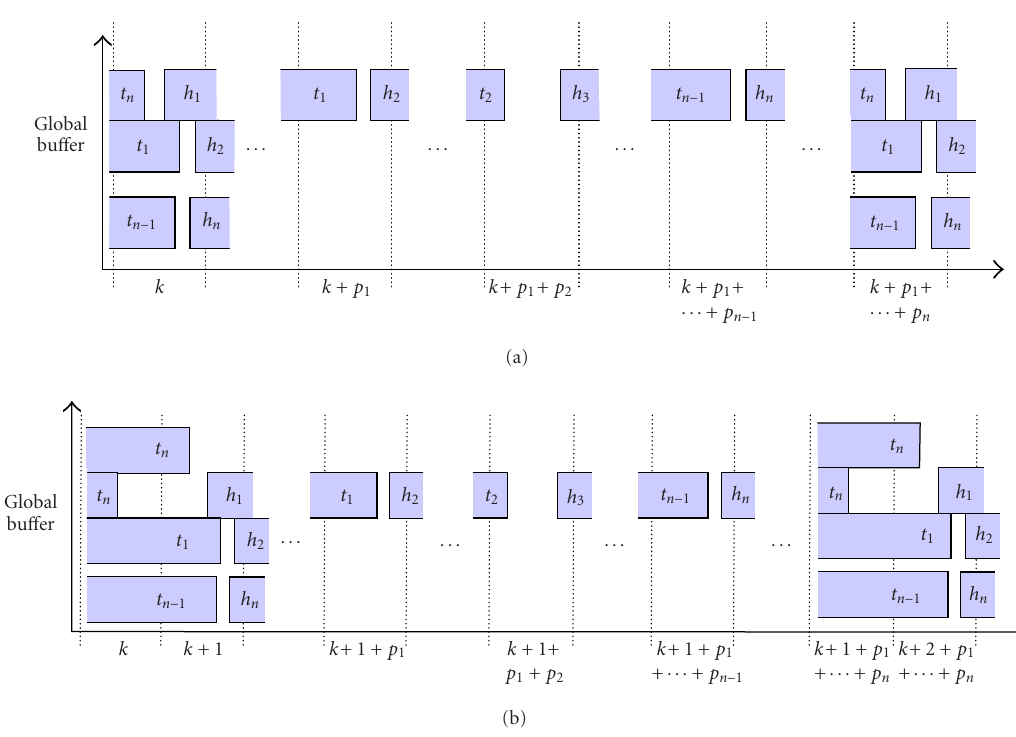
Figure 10: Sample lifetime patterns when multicycle lifetimes are chained so that tail interval t i is chained to the lifetime of sample j + 1. (a) Case 1: t n is chained back to the lifetime of sample 1. The repetition period of sample lifetime patterns becomes chained to none. The repetition period becomes